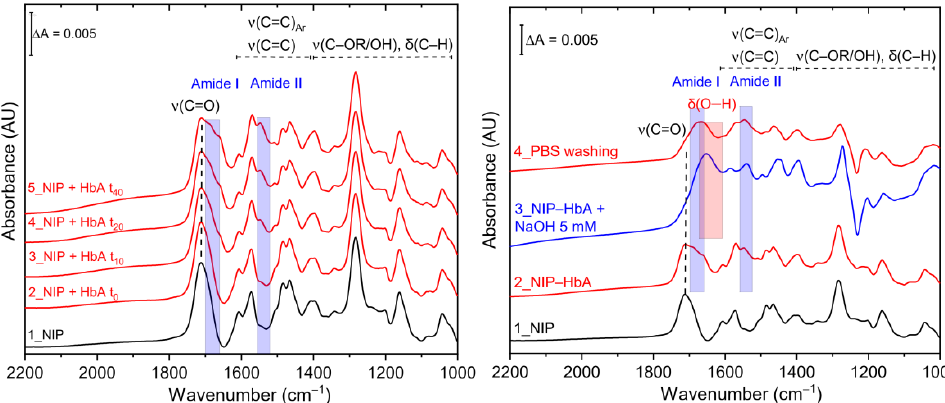
Figure 5. IR absorbance spectra of unspecific HbA binding on NIP. Spectra were recorded at different incubation times (left panel, 0, 10, 20, and 40 min) with 500 µ L of PBS solution containing 0.1 µ M HbA (pH 7.4). Note that after 40 min the electrode was washed with PBS containing 1 M NaCl resulting in no change of the amide I/II bands (trace 5). Washing with 5 mM NaOH (right hind panel, blue spectrum) resulted in NIP degradation, as derived from the disappearance of the absorption at 1715 cm − 1 , while the HbA related amide II band at 1539 cm − 1 band is still detectable (traces 3 and 4).